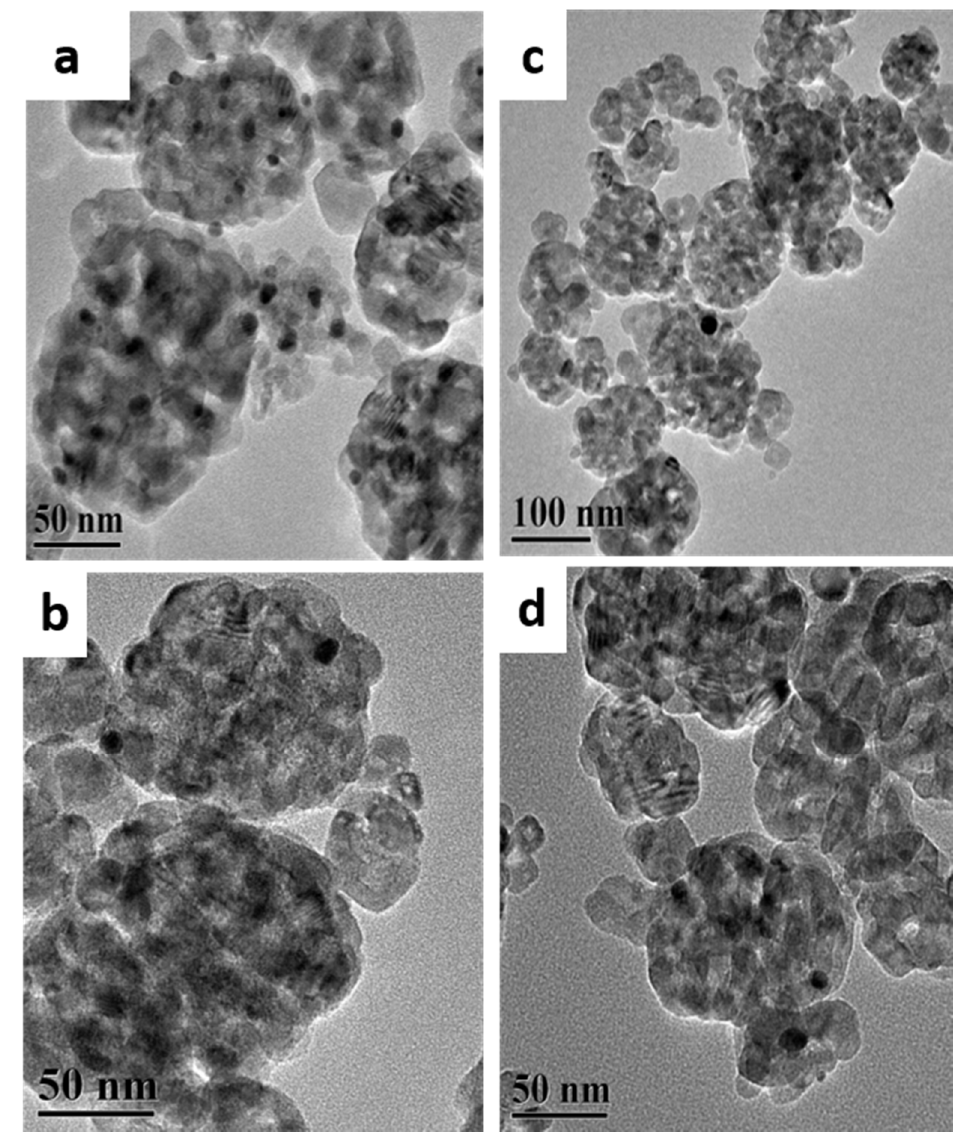
Figure 2. HR-TEM images of ( a ) Au/TiO 2 and Au-FeO x /TiO 2 samples with increasing Fe content; ( b ) Au:Fe = 1:0.5; ( c ) Au:Fe = 1:1; and ( d ) Au:Fe = 1:2.